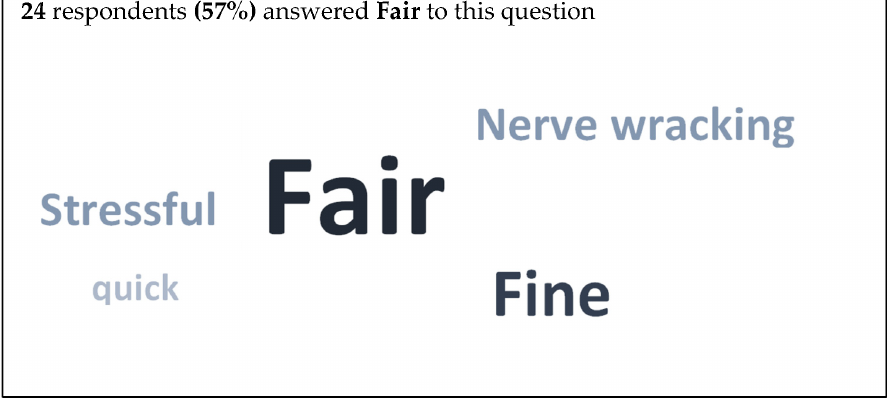
Figure 3. Word cloud: participants were asked for three words to describe the online examination experience.